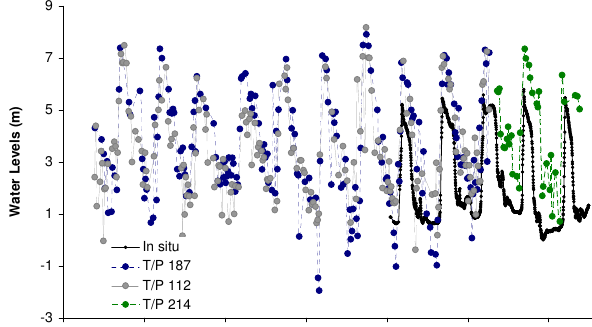
Figure 4. Time series of water levels at Salekhard from in situ gauge (black), T/P altimetry 1 Fig. 4. Time series of water levels at Salekhard from in situ gauge stations. 2 (black), T/P altimetry stations.